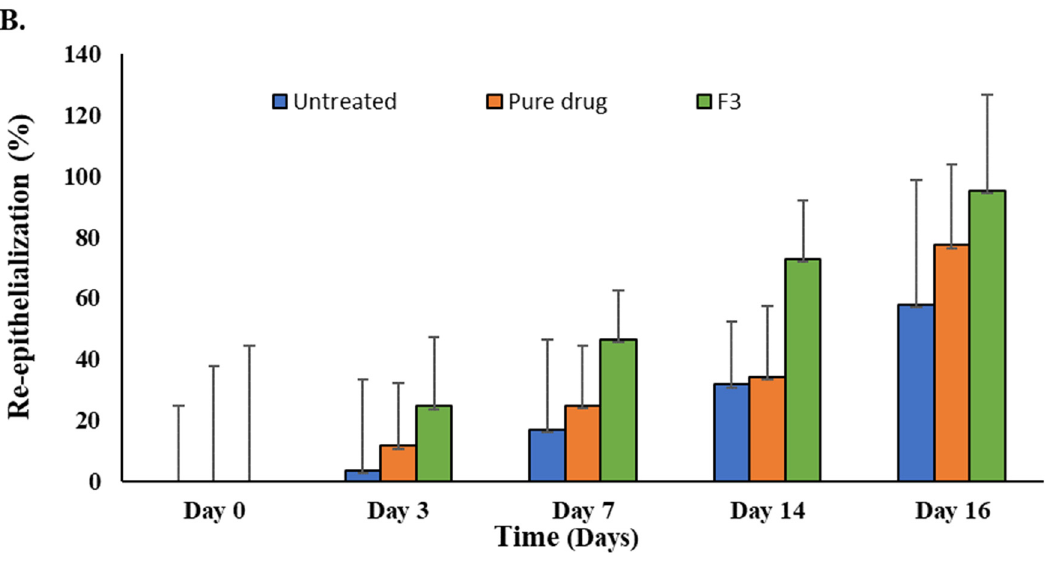
Figure 11. ( A ) Wound sizes (mm 2 ) and ( B ) percentage re-epithelialization in the diabetic rats upon treatment.